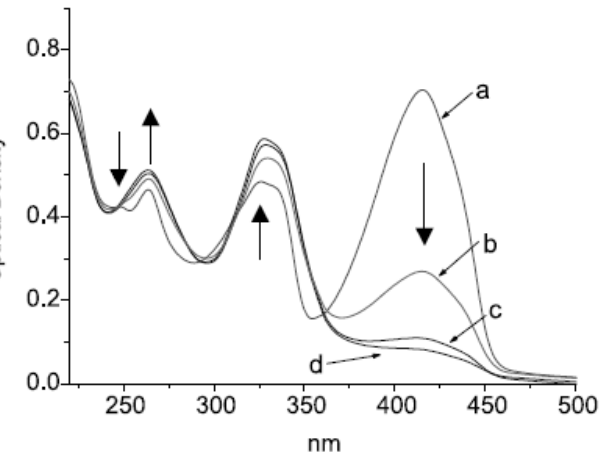
Figure 11. UV spectrum of 4 , trace a in 3-methylpentane at 90 K. b, c, d is after irradiation at 410 nm